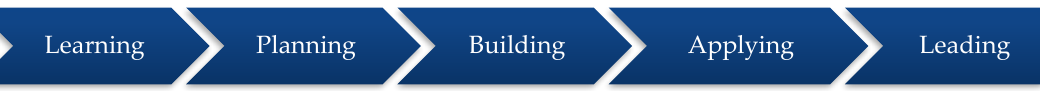
Figure 6. DAMM for Associations—Five Stages of Data Analytics Maturity. Source: own elaboration Figure 6. DAMM for Associations — Five Stages of Data Analytics Maturity. Source: own elaboration based on based on ASAE. Figure 6. DAMM for Associations — Five Stages of Data Analytics Maturity. Source: own elaboration Figure 6. DAMM for Associations — Five Stages of Data Analytics Maturity. Source: own elaboration based on ASAE. based on ASAE.